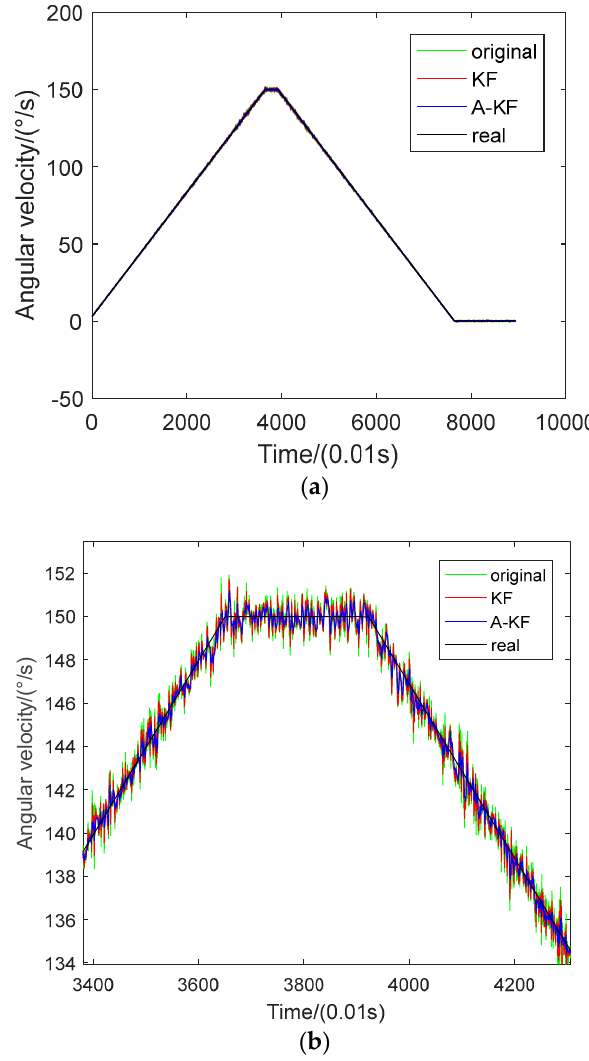
Figure 6. Data comparison between filtering with the Kalman filtering method based on the ARMIA model (KF) method and the Kalman filtering with adjustments (A-KF) method. ( a ) Entirety data comparison; ( b ) part of the data zoomed in.